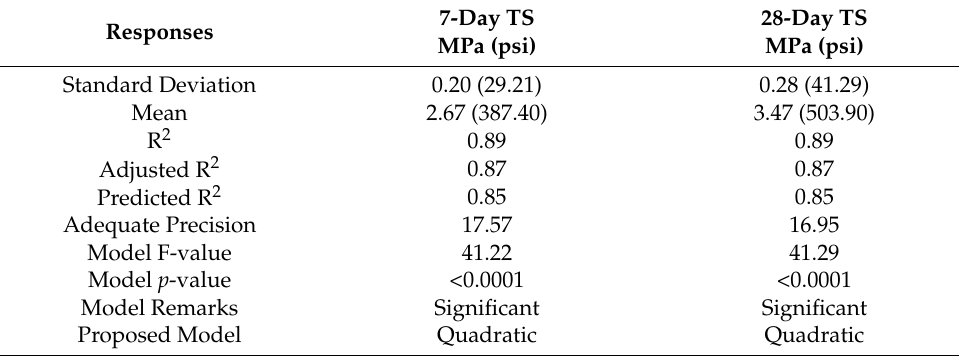
Table 8. ANOVA and fit statistics of tensile